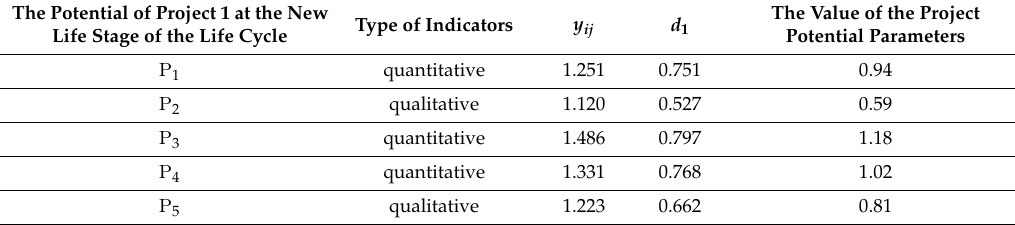
Table 10. Determination of Project 1 potential at the life cycle stage.